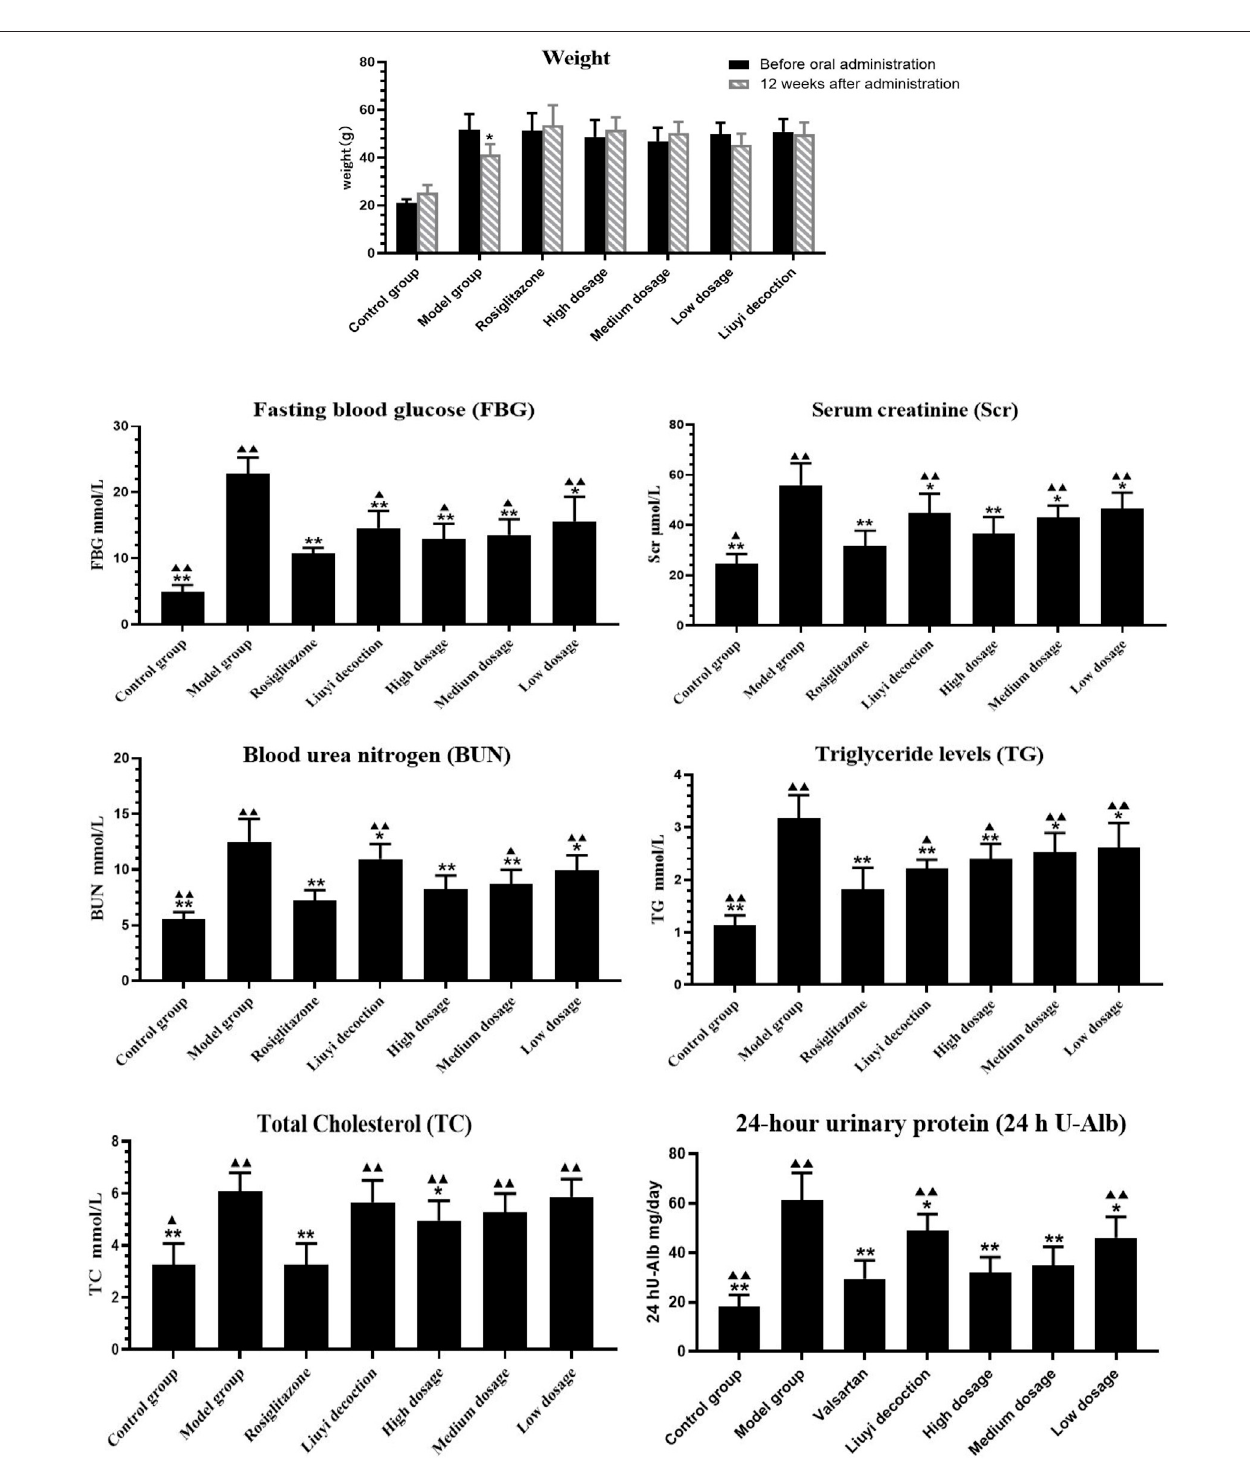
FIGURE2| Resultsofbiochemicalindexesineach group( ‾ x±SD, n =6).ps: vs.Modelgroup, * P < 0.05,** P < 0.01;VSpositivecontrolgroup, ▲ P < 0.05, ▲▲ P < 0.01.